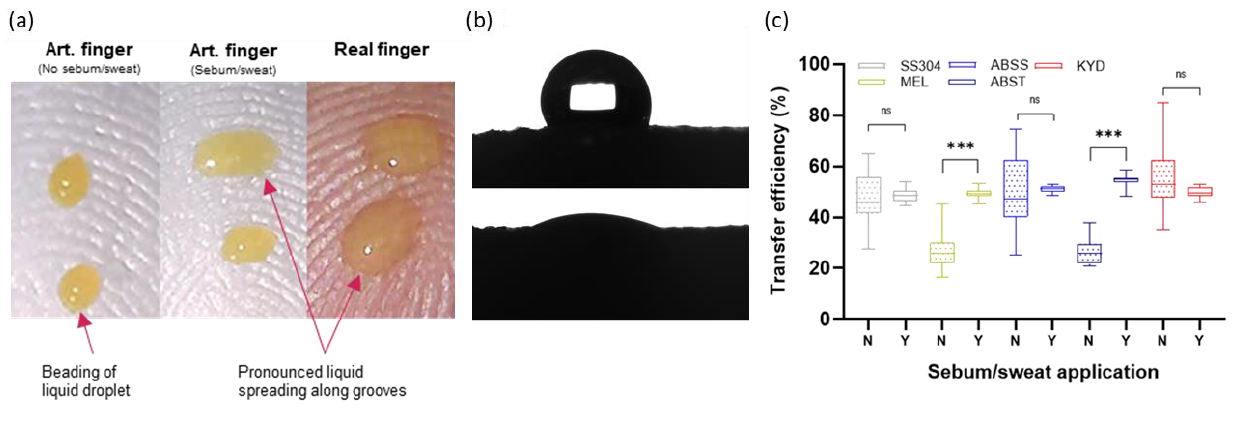
Figure 5. Impact of artificial eccrine sweat–sebum application. ( a ) Effect on surface wettability of artificial finger-pad compared to human finger, ( b ) cross-section photograph of artificial saliva on artificial finger-pad in absence and presence of eccrine sweat – sebum emulsion during measurement of surface energy, and ( c ) effect on transfer efficiency of liquid droplet to artificial finger-pad. *** = significance ( p < 0.05), ns = not significant ( p > 0.05).